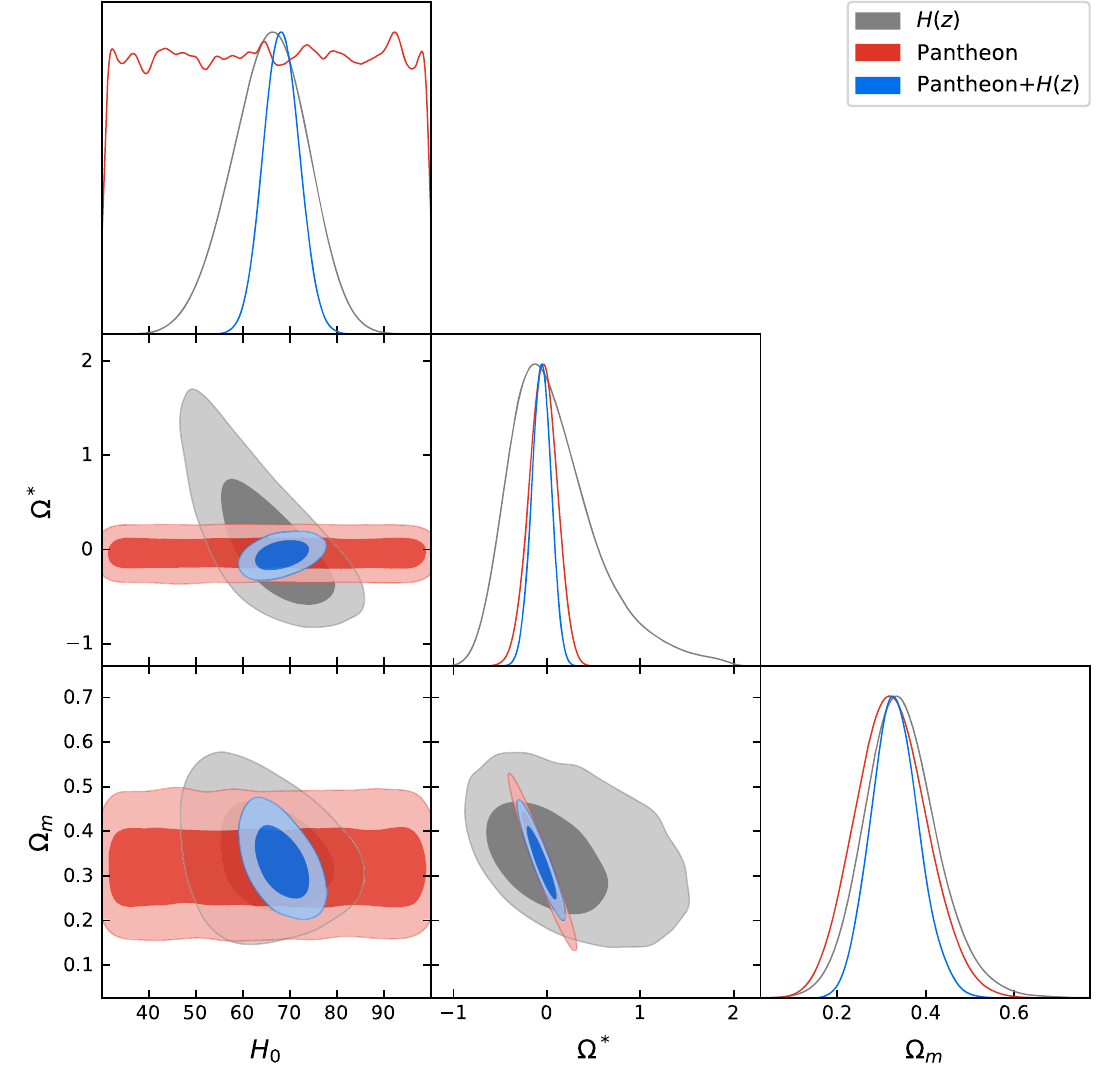
Fig. 3 Case II: Contours of the parameters H 0 , (cid:7) m and (cid:7) ∗ at 1 σ and 2 σ c.l. for the separate set of data of H ( z ) (grey), SNe Ia – Pantheon (red) and the joint analysis